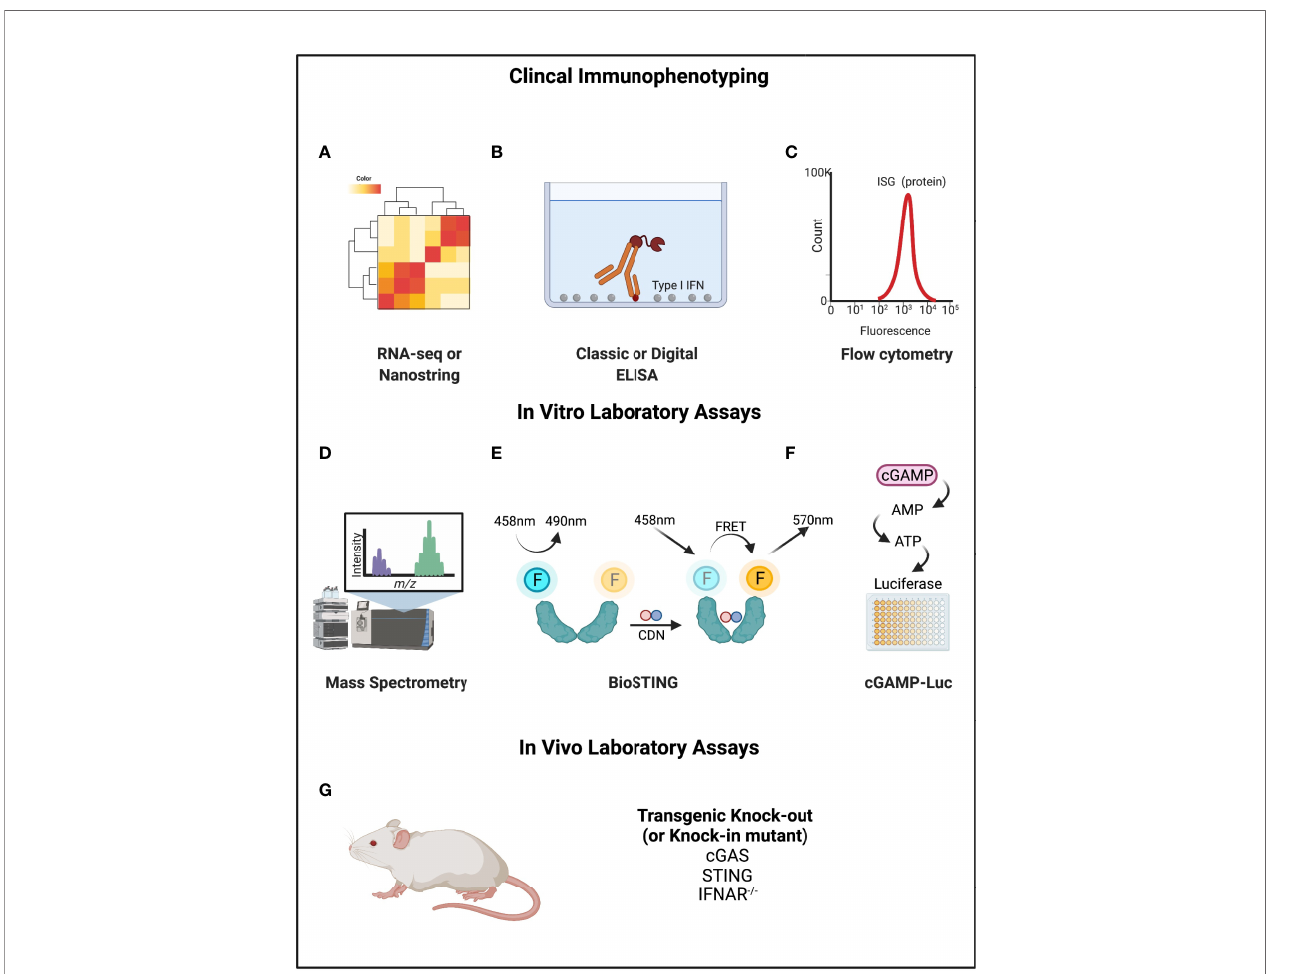
FIGURE 4 | Mechanisms of measuring cGAMP-STING activity. (A – C) RNA-seq or Nanostring, ELISA, and fl ow cytometry can be used to directly detect Type I IFNs or interferon stimulated genes or proteins. (D) Mass spectrometry can be used to measure cGAMP. (E) BioSTING: when CDNs bind to STING, the conformational change permits FRET such that emission occurs at a different wavelength. (F) cGAMP-Luc is based on using ENPP1 to convert cGAMP to AMP (and then ATP), which can be quanti fi ed using a standard luciferase assay. (G) Mouse models exist for STING pathway knockouts and knock-ins of gain-of-function variants that can be disease causing. Created with